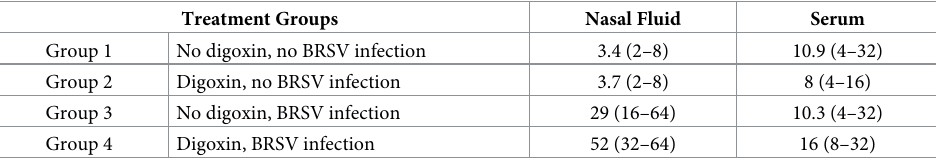
Table 2. Neutralizing antibody titers in nasal fluid and serum on day 10 post